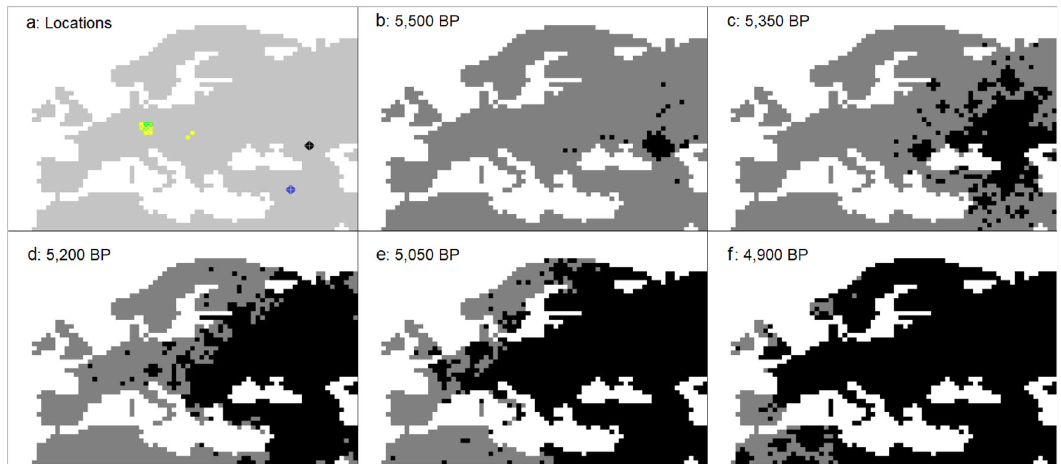
Fig. 1 Illustration of the simulation map. Each colored cell represents 100 by 100 km of land. The white cells represent water. a ) Simulated sampling locations; light to dark green represents 1 – 10 diploid paleogenomes per deme (see Table 1), the blue dot shows the chosen source for the farmer layer, and the black dot shows the chosen source for the pastoralist layer. b – f ) Example of the simulation of pastoralist dispersal short- and long-distance migrations. The dark gray cells contain populations that precede the pastoralists, whether they were farmers or hunter-gatherers, and the black cells also contain the